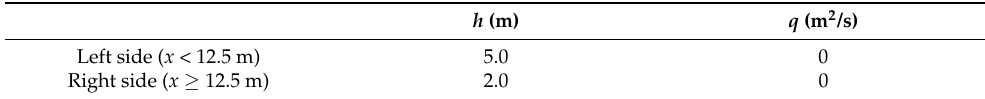
Table 3. Initial conditions for a homogeneous case of one rarefaction and one hydraulic bore in a frictionless, horizontal